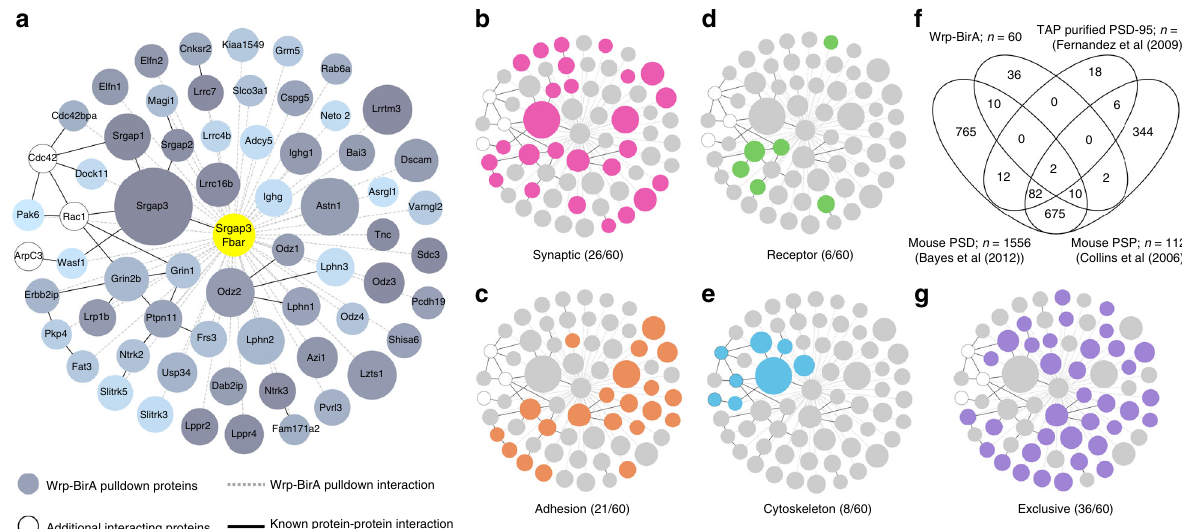
Fig. 2 Proteome of developing dendritic protrusions. a Wrp-BirA-dependent iBioID identi fi ed a network of known and unknown proteins enriched in dendritic fi lopodia early in spinogenesis. Node titles correspond to the gene name, size represents fold enrichment over the BirA negative control (range 2.45 – 23.73), shading represents p -value with light gray being a lower p -value and darker gray a higher p -value (range 9.06 × 10 − 5 – 0.05). Edges are marked according to type of interaction. Dashed lines are iBioID interactions where as solid lines are previously known interactions identi fi ed in the Genemania, Biogrid, or String databases. b Clustergram of synaptic proteins (pink) as identi fi ed through DAVID analysis or the G2C database of Cortex PSD Consensus proteins 38 . c Clustergram of adhesion proteins (orange) as identi fi ed through DAVID analysis. d Clustergram of receptor proteins (green) as identi fi ed through DAVID analysis. e Clustergram of cytoskeletal proteins (blue) as identi fi ed through DAVID analysis. f Venn diagram of Wrp-BirA proteome compared to three previously published proteomes of mature postsynapses. g Clustergram of proteins found exclusively in the Wrp-BirA network in comparison to mature postsynaptic proteomes